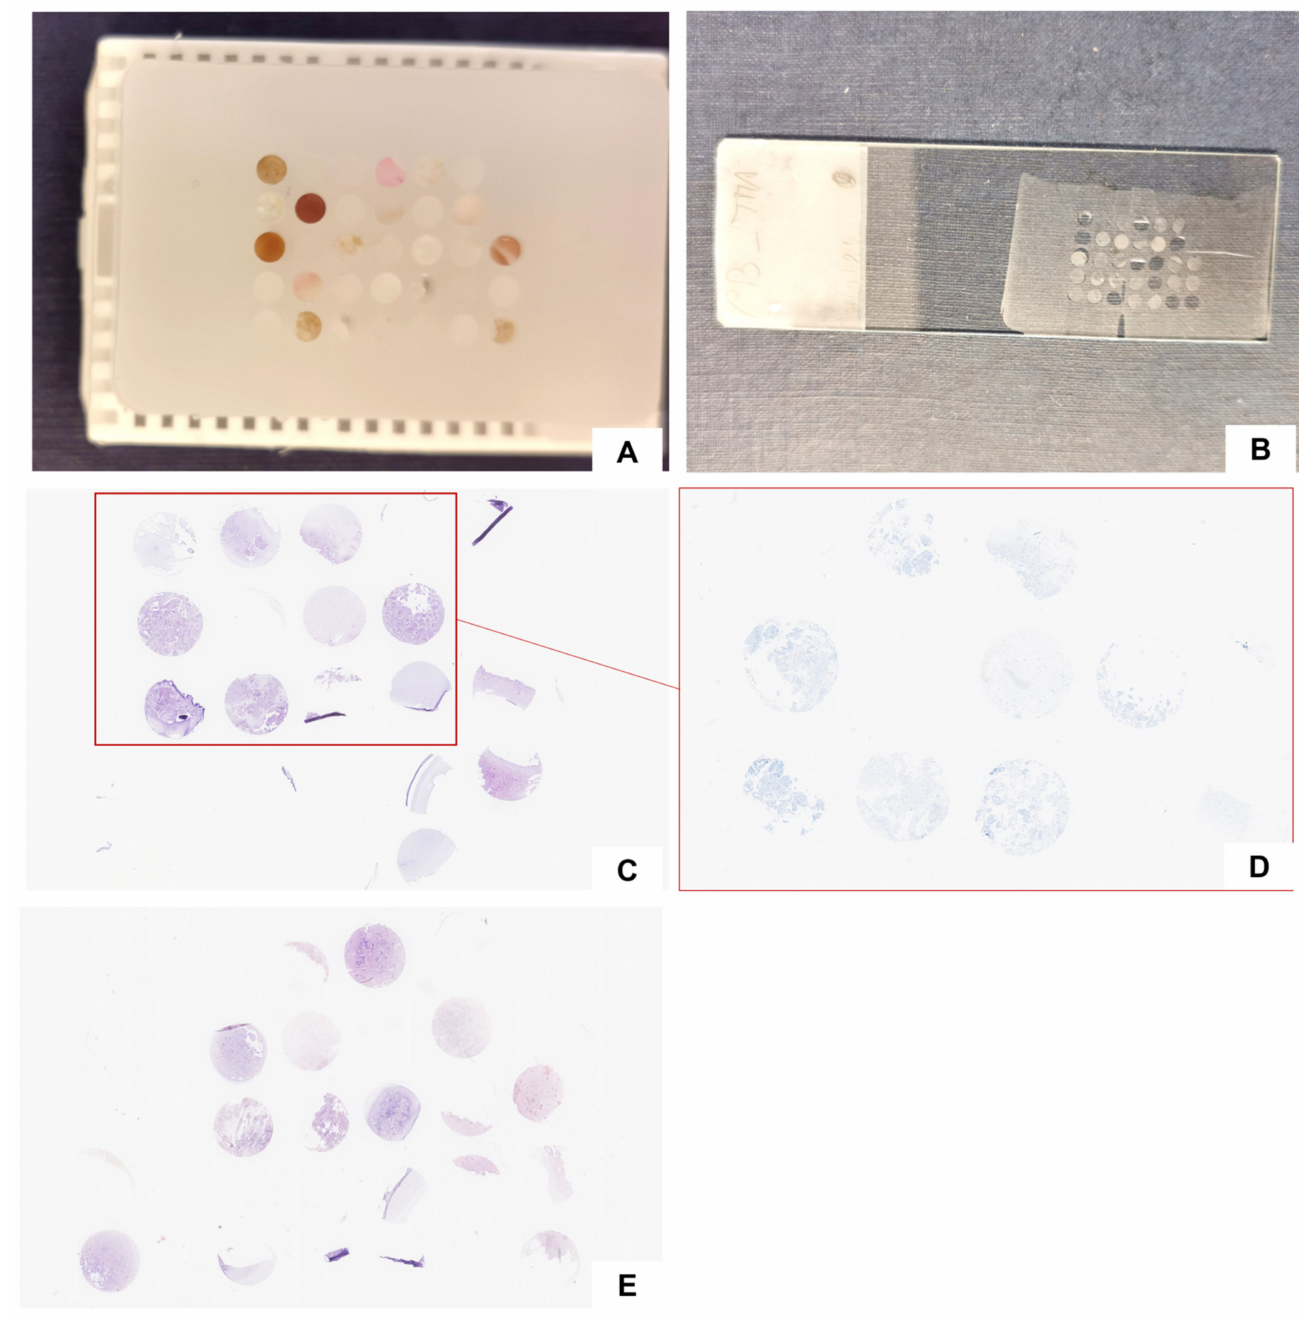
Figure 1. Cell-block-derived TMA construction: TMA paraffin block ( A ) and an unstained section ( B ); two representative hematoxylin and eosin-stained sections (section numbers 5 ( C ) and 20 ( E )) and the corresponding PD-L1-stained section ( D